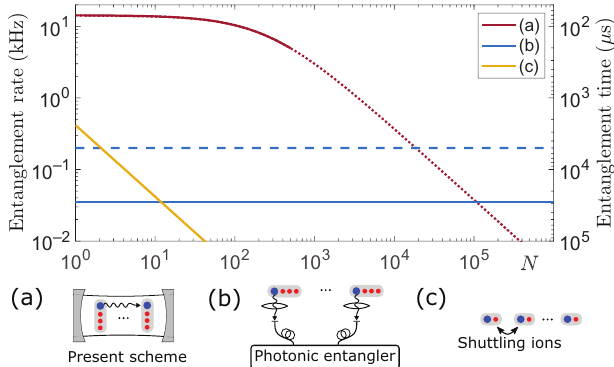
FIG. 4. Comparison of the average rates for distributing entan- glement to M any-to-any-connected local processors comprising N total qubits for different modalities (a)–(c). (a) Red line: intra- cavity entanglement method proposed here with 25 ions per chain using the parameters outlined in this section, with the entanglement time given by (τ parallel + 1 M τ serial )/ p , and where 2 p = 0.40, τ serial = 5.3 μ s (see the Supplemental Material [49]), and τ parallel = 28 μ s [52]. The red line changes from solid to dashed at N = 500, representing the number of ions that could be fit comfortably in a single rf trap along the cavity axis. (b) Blue lines: photonic interconnects with 25 ions per chain using the method of Refs. [29,31,53] can entangle many pairs of ion chains in parallel if the photons are routed through an optical cross- connect switch. The dashed blue line shows the current state of the art for entangling two ions (5 ms) [32], and the solid blue line shows the same with additional realistic overheads necessary for achieving high-fidelity full connectivity, including a factor of 2 overhead for entanglement purification [32,54], cross-connect switch insertion losses (1.3 dB per photon), and switching time (10 ms overhead) [55,56]. (c) Yellow line: ion shuttling archi- tectures [57,58], where ions are physically transported between different ion traps, require milliseconds of sympathetic re-cooling after each split/merge operation. Demonstrated geometries (two ions per local processor, see [25]) lead to linearly increasing transport time for fully connected